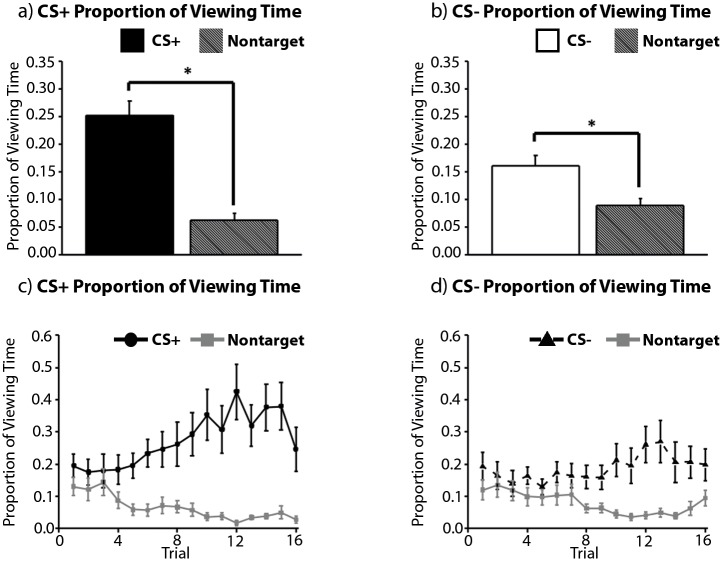
Eye Movement Data.(top) Global averages, collapsed across all of the experimental trials. Participants directed more viewing time to both the CS+ (a) and the CS- (b) than to non-target comparison objects embedded in the same scenes; this preferential viewing effect was more robust for the CS+ than the CS-. (bottom) Trial-by-trial illustration of the eye movement data. Disproportionate viewing of the CS+ (c) and the CS- (d) relative to the non-target comparison object became increasingly robust across trials, and was greater for the CS+ than for the CS-. Error bars show SEM.